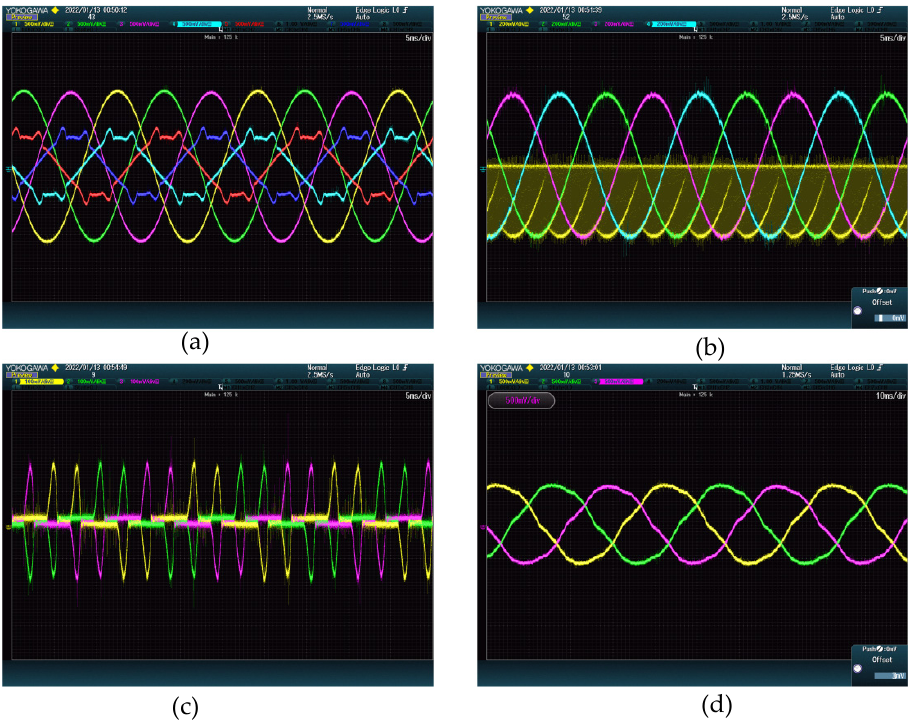
Figure 16. Oscilloscope image of the results of case study 1/scenario C. From left to right, top to bottom: ( a ) diesel generator phase voltages and currents; ( b ) battery currents (at the battery itself and at the output of the filter); ( c ) input currents to the propulsion system; ( d ) stator currents of the induction motor.